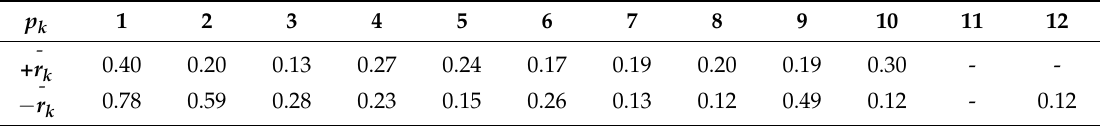
Table 2. Positive and negative correlation averages of band ratio candidates for components 1–12 in selected subset of the study